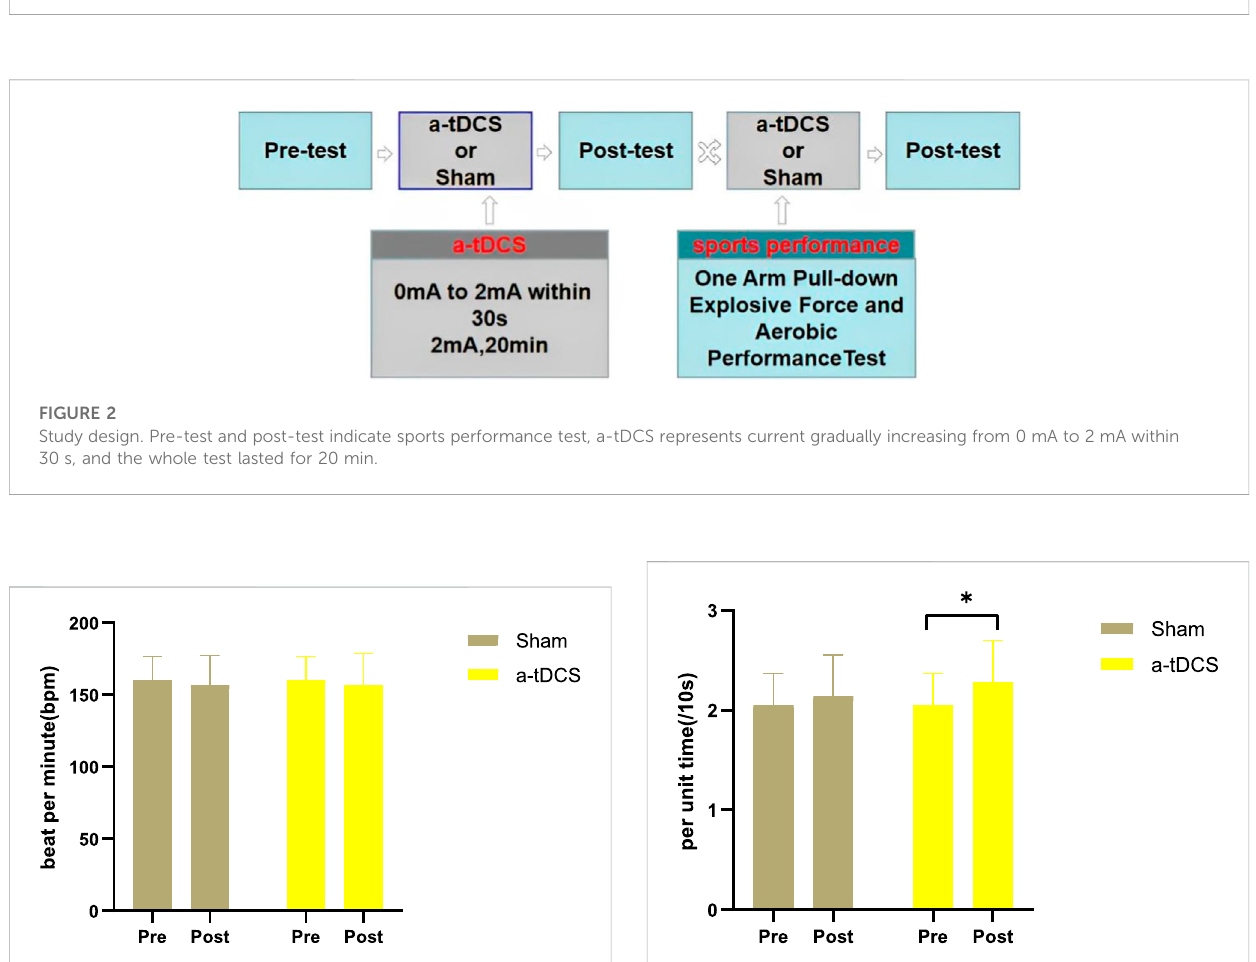
FIGURE 3 Immediate heart rate after 9-min aerobic activity. The white bars represent real stimulation compared to pre-stimulation, and the gray bars represent sham stimulation compared to pre-stimulation. “ Pre ” means before stimulation, and “ post ” means after stimulation.